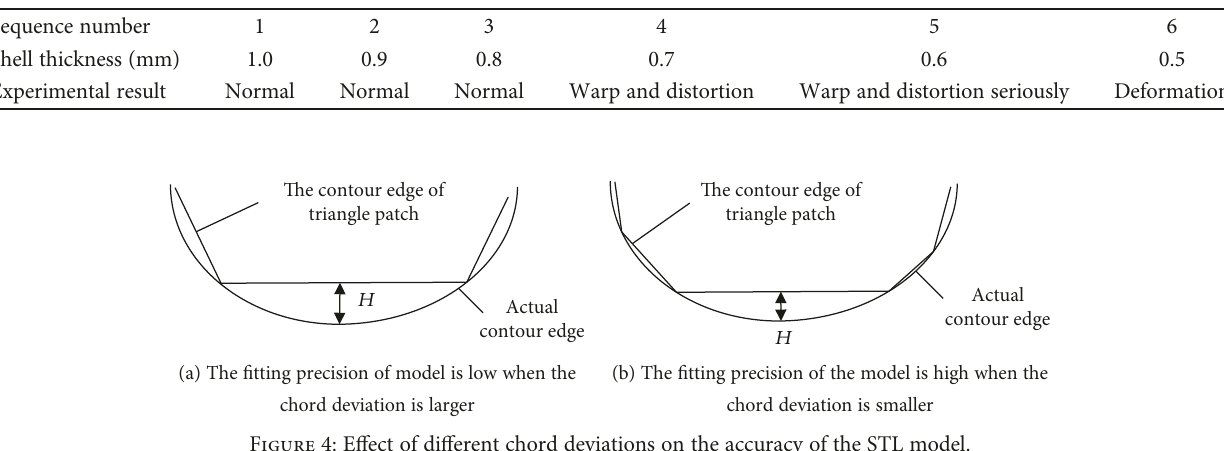
Table 3: Setting of the shell